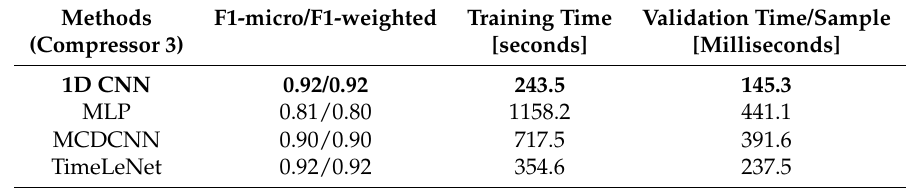
Table 4. Comparison of the performance with state-of-the-art methods (in bold, the best ones).